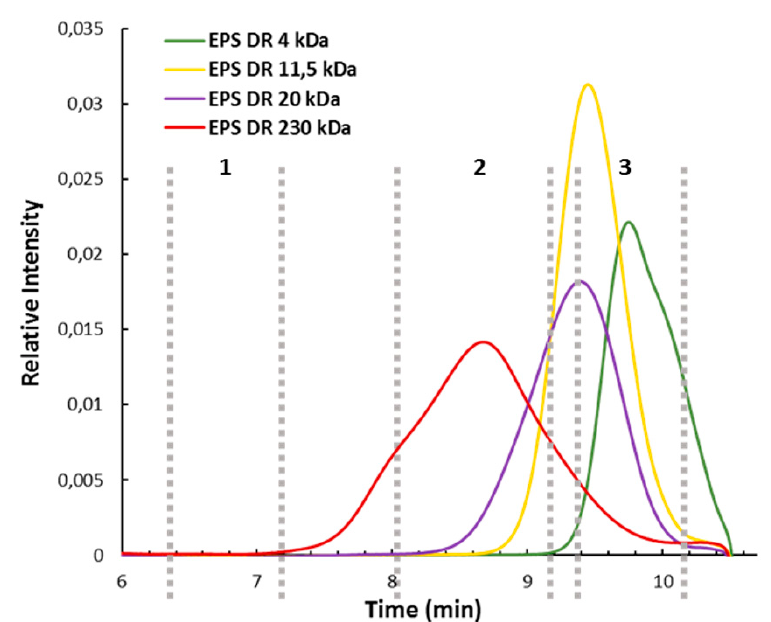
Figure 4. High pressure size exclusion chromatography with multi angle light scattering (HPSEC-MALS) profiles of the GY785 EPS derivatives (EPS DR) of weight-average molecular weights of 4,000, 11,500, 20,000 and 230,000 g/mol.